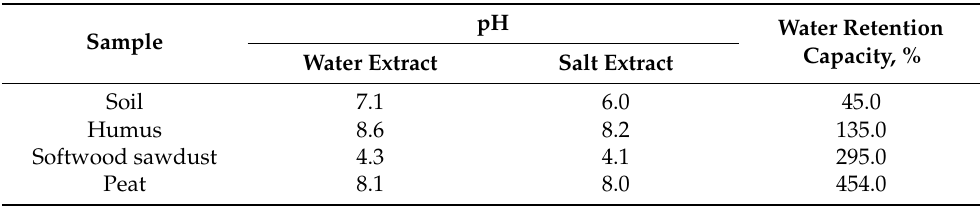
Figure 5. Average survival rate of English oak seedlings in containers with different substrate composition Variant: 1. Soil (control); 2. Peat:S = 1:1; 3. Peat:S = 1:2; 4. Peat:S = 2:1; 5. Peat:S = 3:1; 6. S:H:SD = 1:1:1; 7. S:H:SD = 2:1:1; 8. S:H:SD = 3:2:1; 9. S:H:SD = 4:2:1 (P—peat; S—soil; H—humus; SD—sawdust). Table 3. Results of physical and agrochemical analyses of the components of substrates used in growing English oak seedlings in containers.